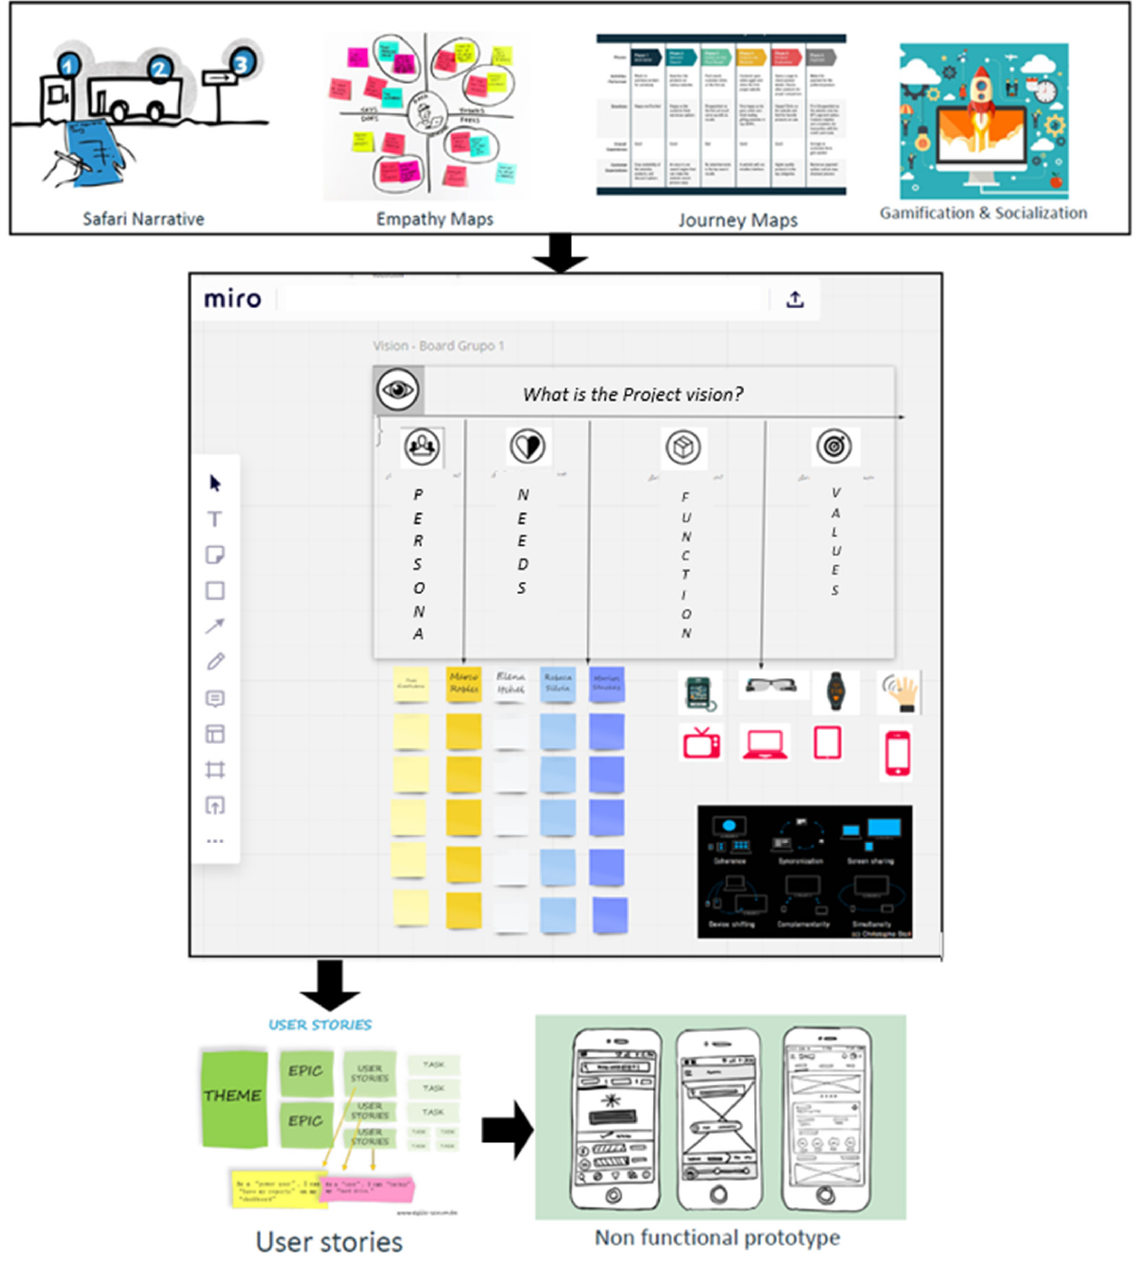
Figure 3. Activities to design the User Interface of the demand home energy management system with IoT.